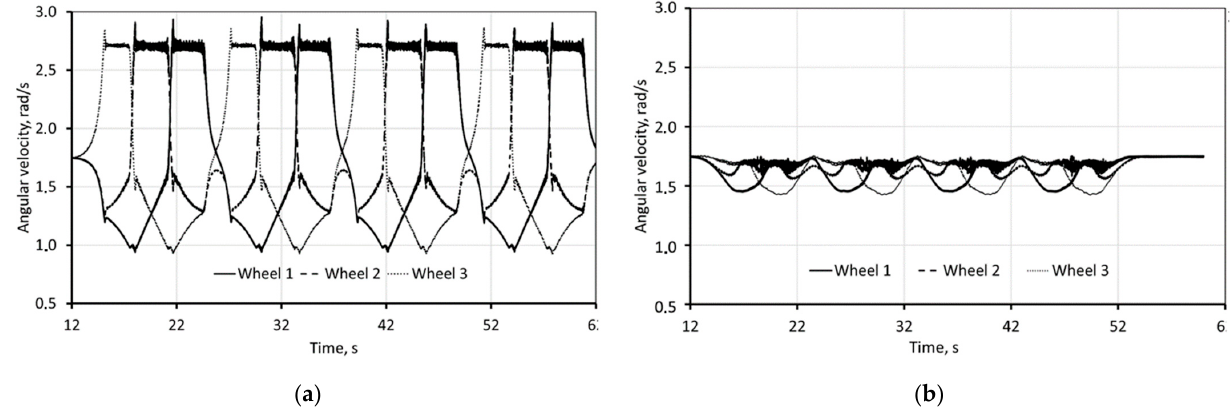
Figure 15. Angular wheel velocity with 25% of nominal pump flow for model with spool flow divider ( a ) and for model with gear flow divider ( b ).